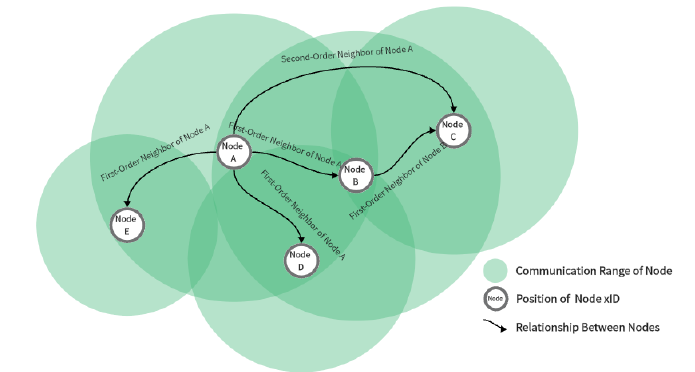
Figure 2. Illustration of neighbors of Node A. Dots in the figure denote sensor nodes, and the ring with the same color as a node indicates the communication range of the node. Nodes B, D, and E are the first-order neighbors of Node A because they are within the communication range of Node A. Node C is the second-order neighbor of A because it is the first-order neighbor of B while not a first-order neighbor of